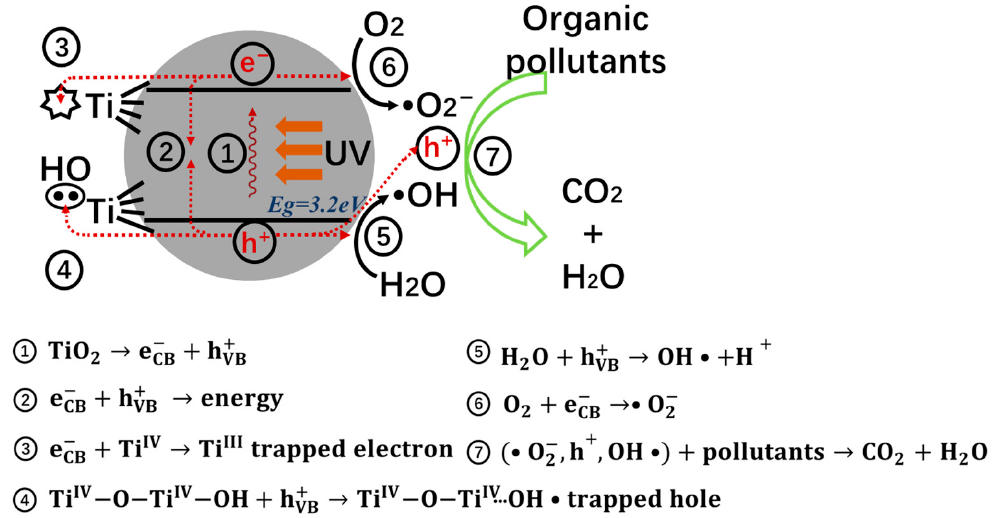
Figure 2. Primary steps in the mechanism of TiO 2 photocatalysis [66]. Copyright 1995, American Chemical Society.